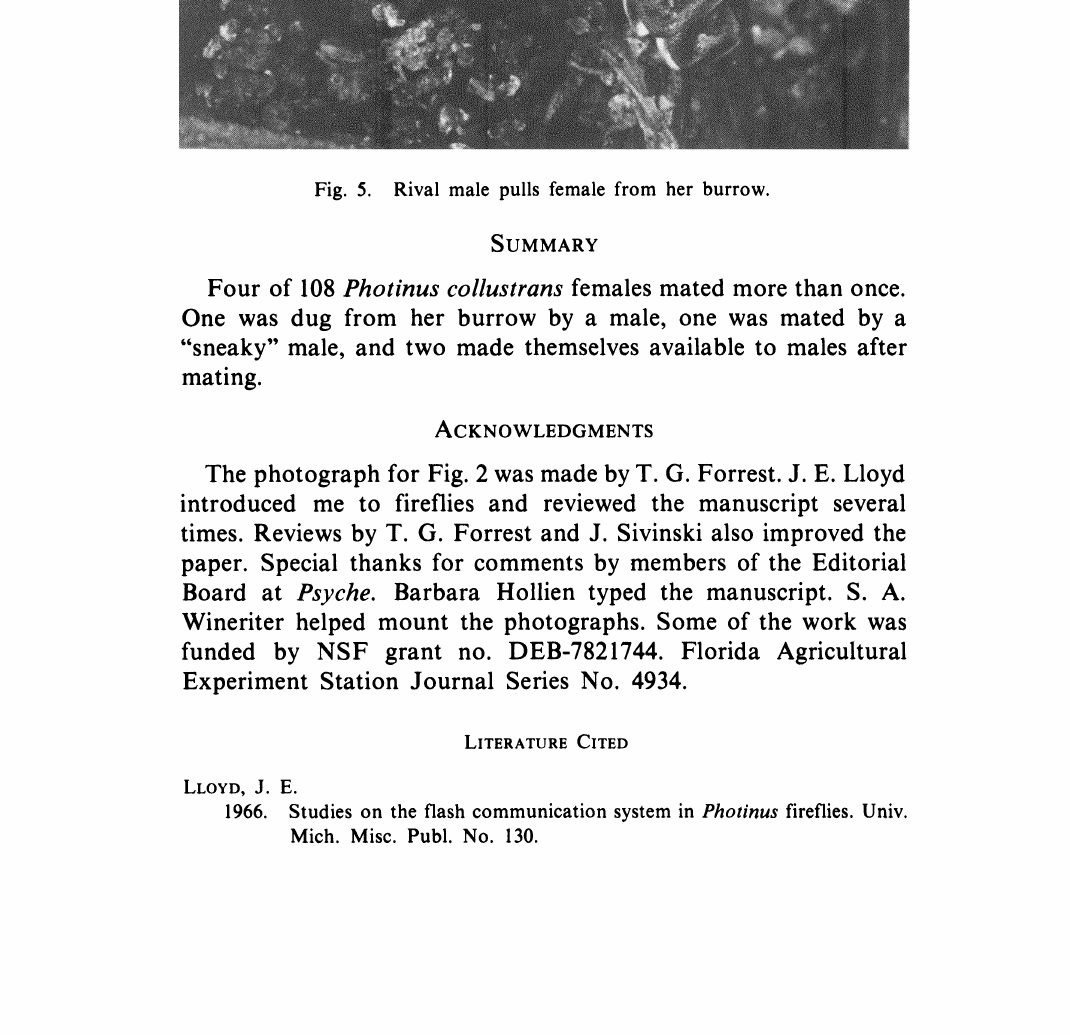
Fig. 5. Rival male pulls female from her